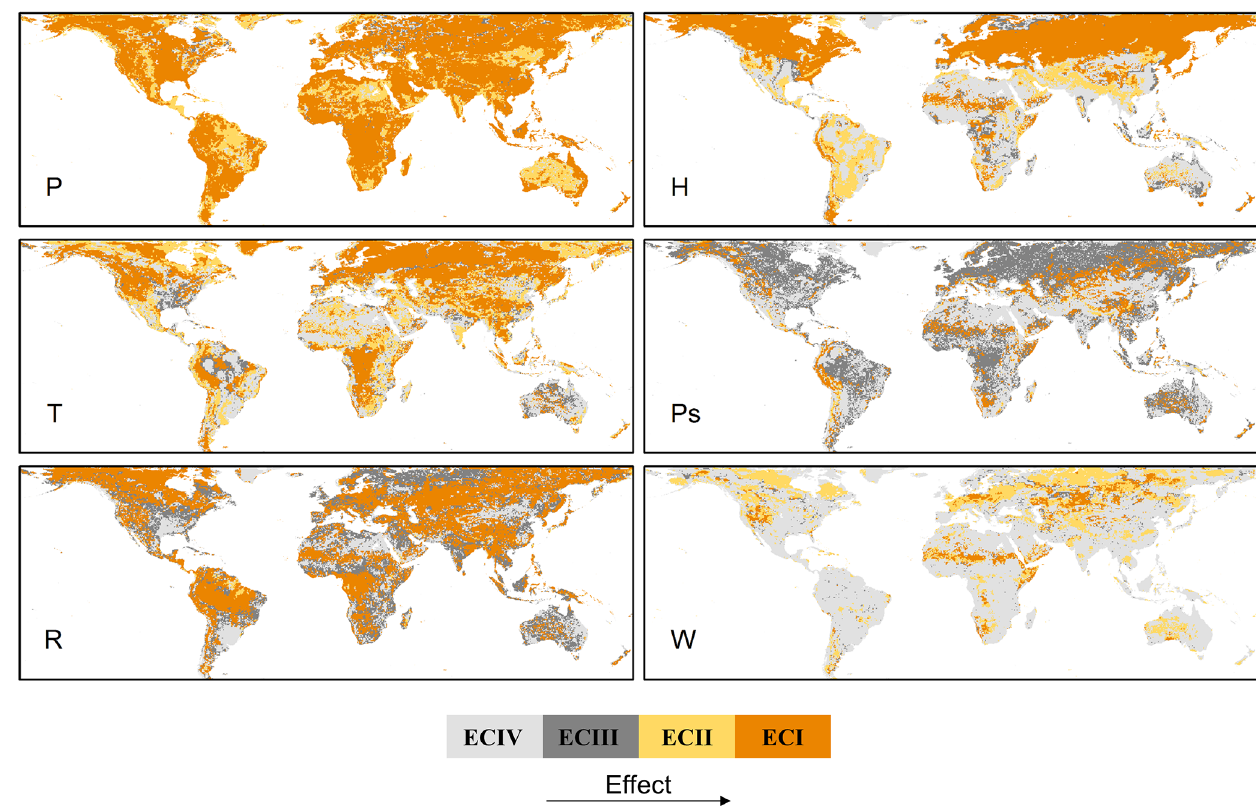
Figure 10. Global maps of bias effect categories (ECs) for each forcing variable.